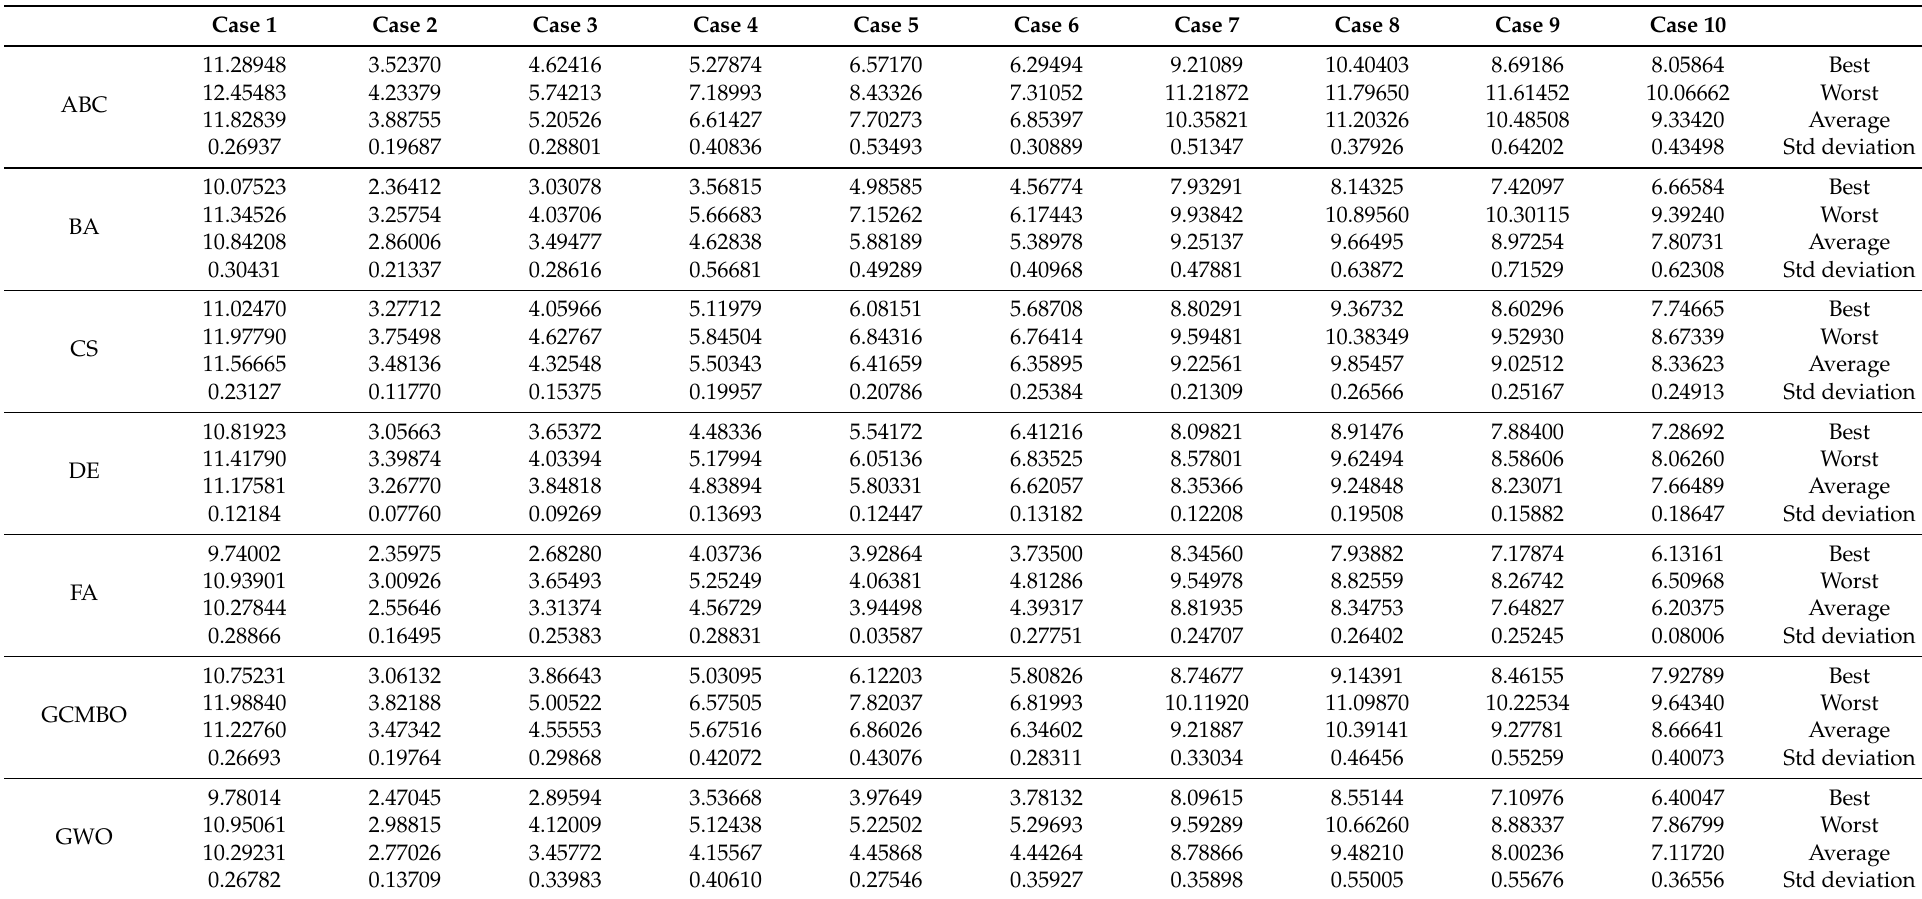
Table 4. Performance comparison of different swarm intelligence algorithms for large-scale UCAV path-planning. The best, worst, average and standard deviation over 25 runs of each algorithm for ten cases are provided. The best values are in